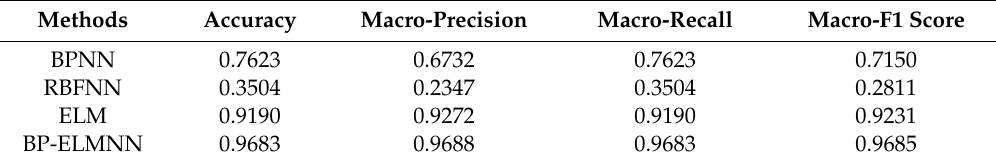
Table 5. The accuracy, macro-precision, macro-recall, and macro-F1 score of the four methods for the